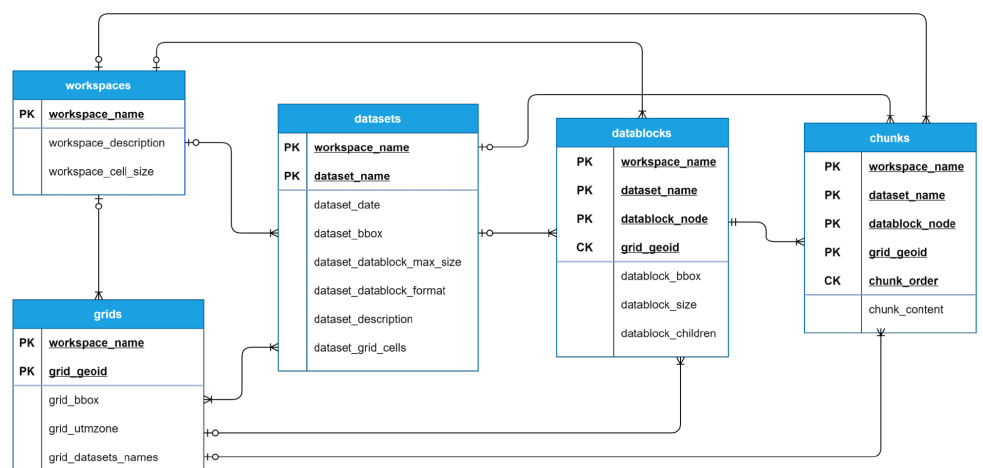
Figure 4. Database design for Cassandra implementation. PK refers to primary key and FK to foreign key.